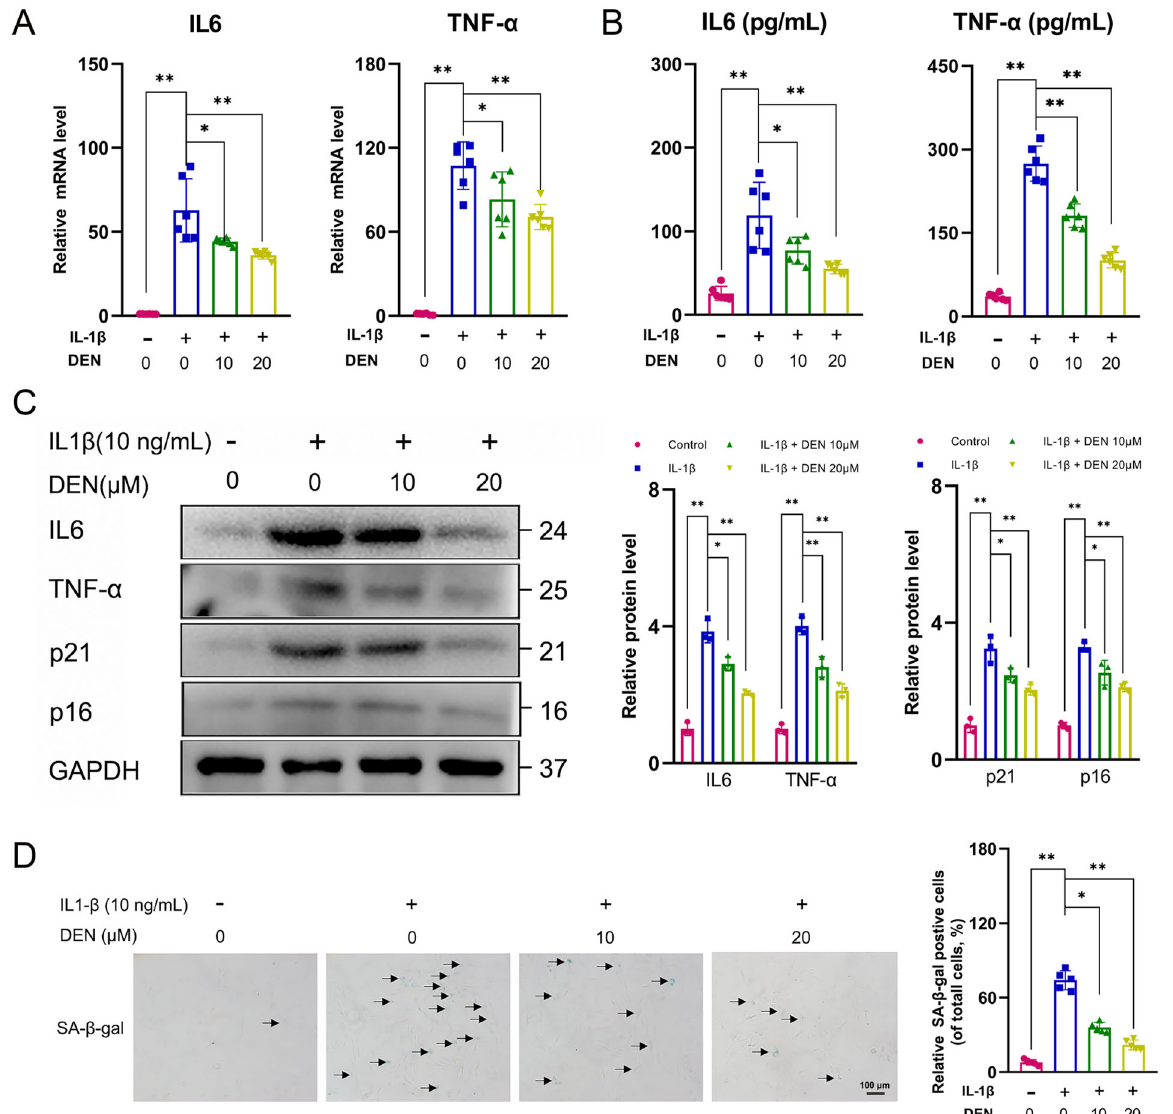
Figure 3. Effect of dendrobine (DEN) on senescence-associated secretory phenotype (SASP) factors expression and senescence phenotype in IL-1 β -induced chondrocytes. ( A ) The expression levels of IL6 and TNF- α were shown in the results of RT-qPCR, n = 6. ( B ) The levels of IL6 and TNF- α in the cell supernatants were detected by ELISA, n = 6. ( C ) The protein levels of IL6, TNF- α , p21, and p16 in chondrocytes were presented by Western blotting, n = 3. ( D ) SA- β -gal staining in chondrocytes, n = 5. The data are shown as mean ± SD. * p < 0.05, ** p <